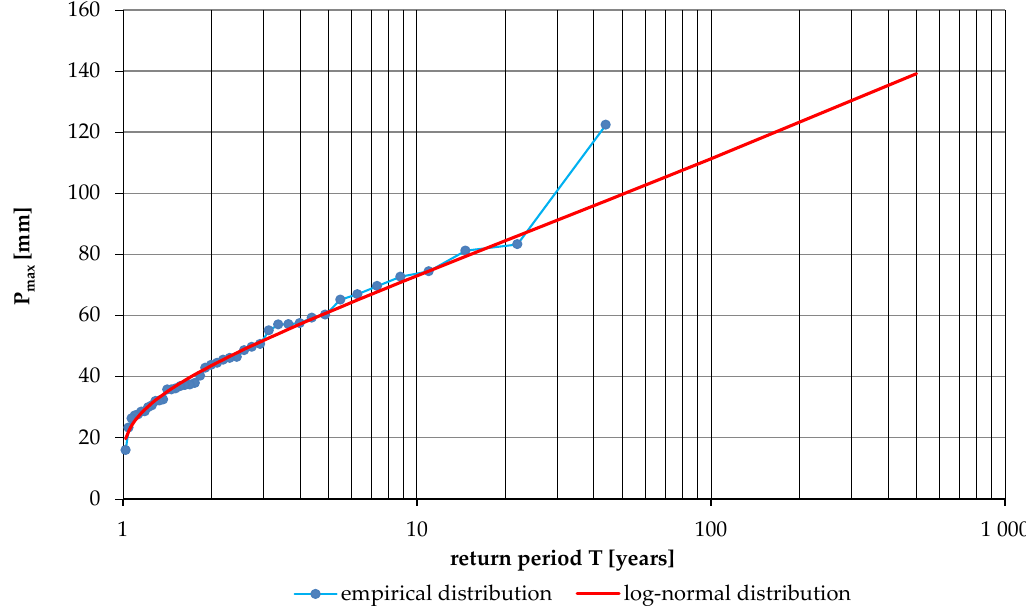
Figure 2. Probability distribution curve for P max.